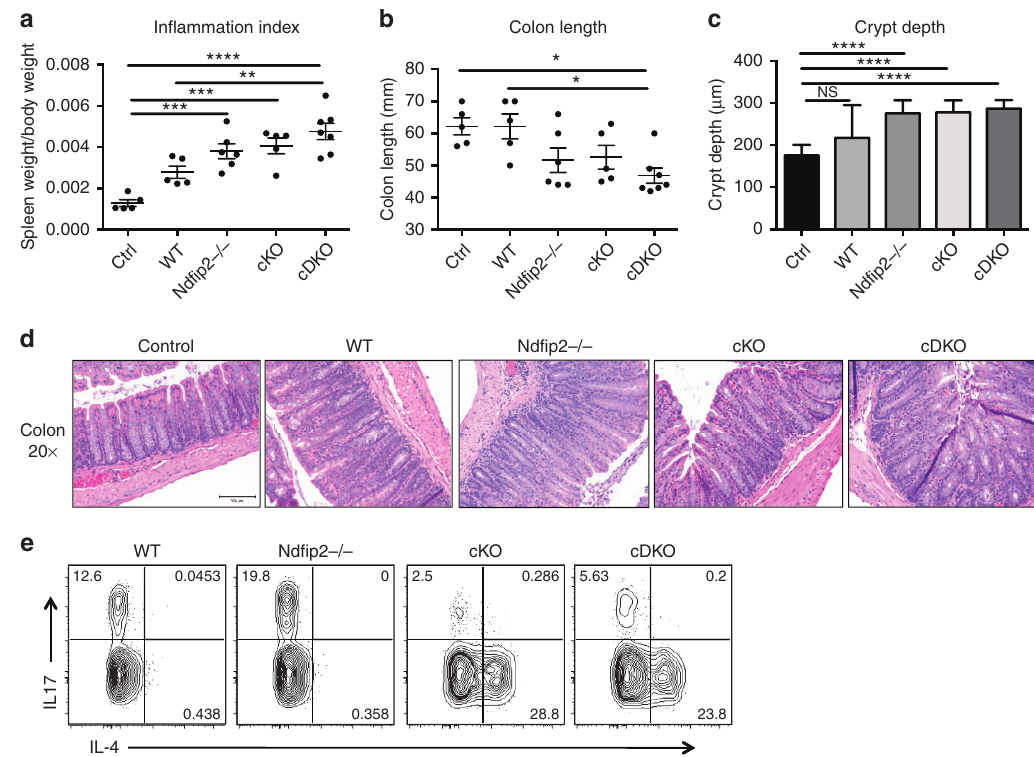
Figure 4 | Ndfip1/Ndfip2-deficient CD4 þ T cells cause increased colitis. ( a – e ) 0.5 (cid:3) 10 6 sorted naive CD4 þ Tcells from WT, Ndfip2 (cid:2) / (cid:2) , cKO and cDKO mice were transferred into 6-week-old Rag1 (cid:2) / (cid:2) recipients. Mice were weighed twice weekly and killed 6 weeks after transfer when 20% weight loss was observed in multiple mice. Spleen weight and body weight were compared to generate an inflammation index ( a ) and colons were measured ( b ). H&E-stained sections of the distal colon were imaged on the (cid:3) 20 objective, and crypt depth was quantified ( c , d ). Splenocytes were stained for intracellular IL-4 and IL-17 after ex vivo stimulation with PMA/ionomycin in the presence of BFA, and analysed by flow cytometry ( e ). Previously gated on live singlets, CD4 þ , dump gate-. Quantifications shown ± s.e.m. n ¼ 5–7 mice. Control (ctrl) mice did not receive Tcells. P values calculated by ordinary one-way ANOVA with Holm–Sidak test for multiple comparisons: * P o 0.05, ** P o 0.01, *** P o 0.001, **** P o